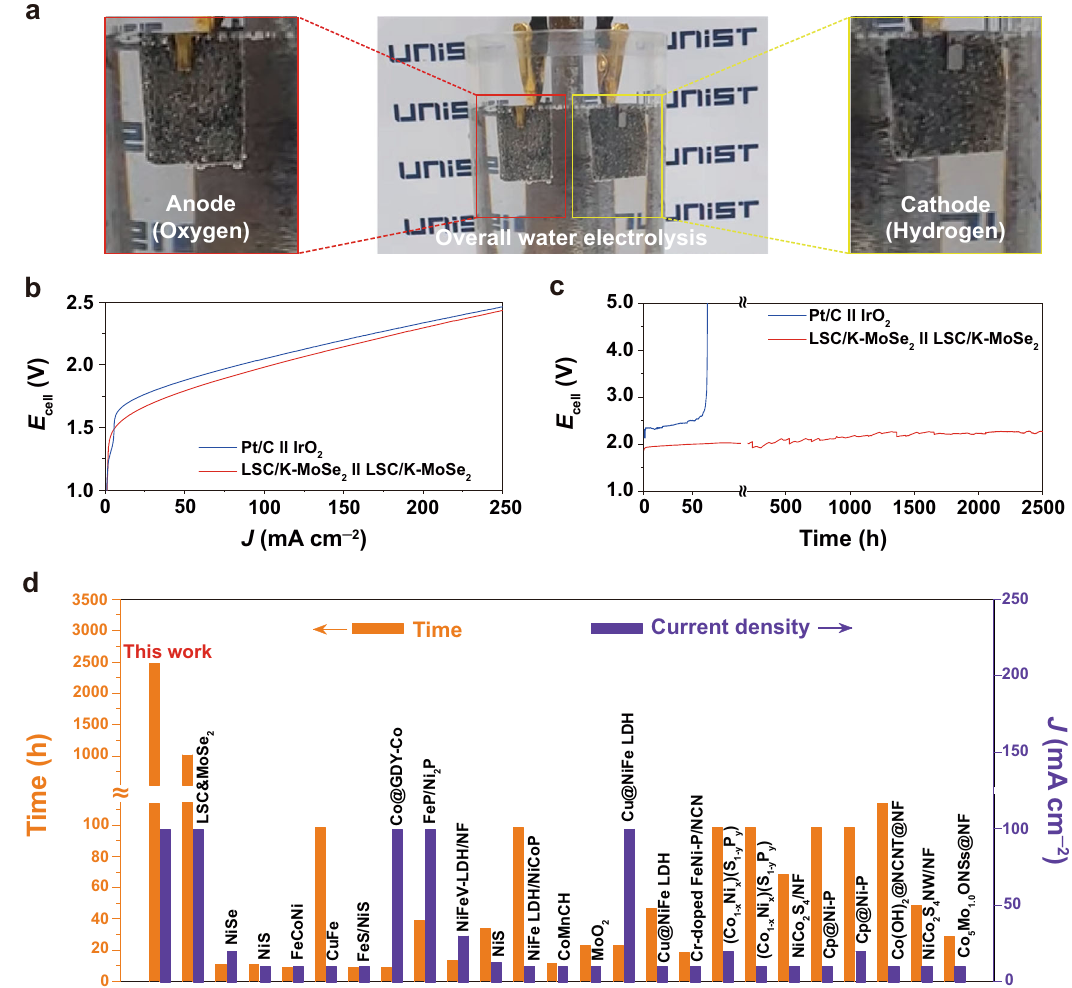
Fig. 5 Overall water electrolysis of LSC/K-MoSe 2 . a Digital image of full-cell water-splitting system comprising a two-electrode con fi guration with LSC/K- MoSe 2 ||LSC/K-MoSe 2 . b , c LSV and chronopotentiometric durability curves of Pt/C||IrO 2 and LSC/K-MoSe 2 ||LSC/K-MoSe 2 measured in 1 M